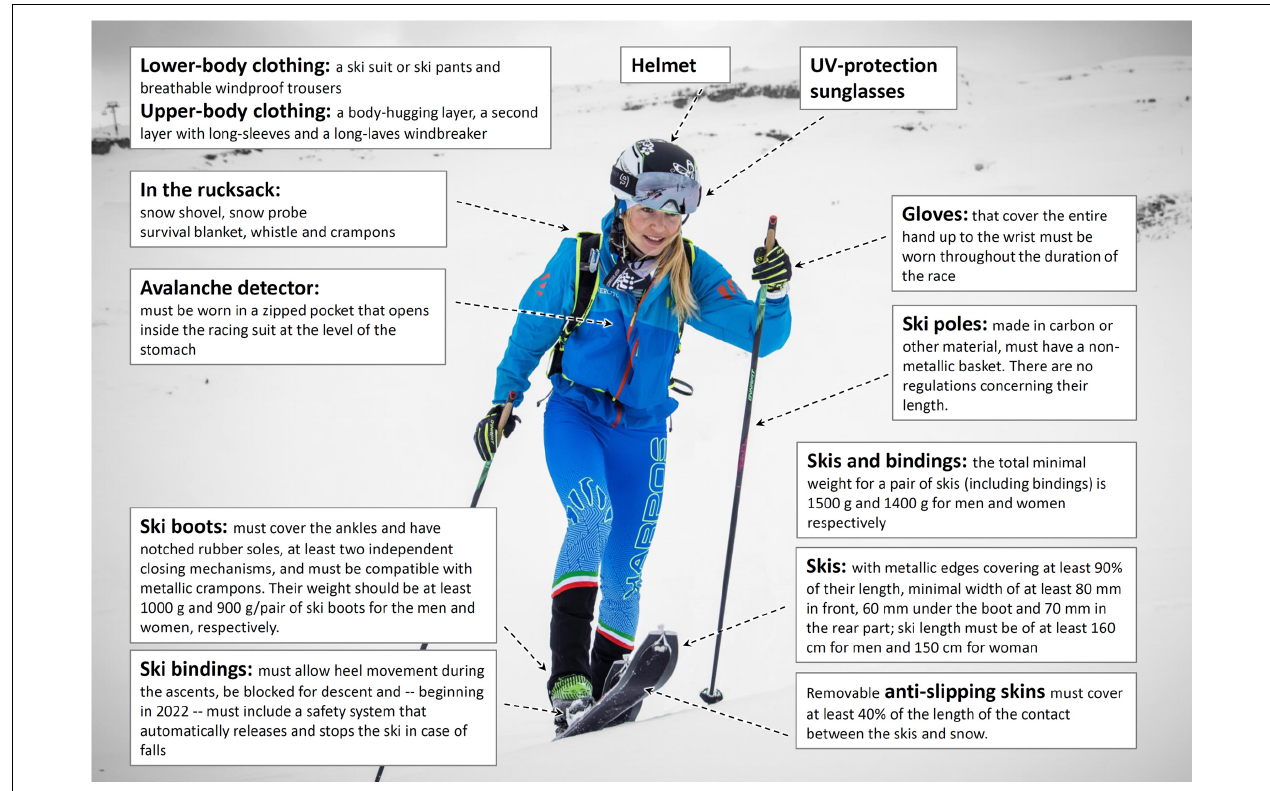
FIGURE 1 | Major features of the equipment utilized during ski mountaineering competitions. Safety equipment, as well as clothing designed to protect against excessive cold, have must be worn. In addition, supplementary equipment and additional clothing may be required for specific events, depending on the characteristics of the course and/or weather conditions. All of this equipment must be borne throughout the race and may be inspected at any time (photo: Maurizio